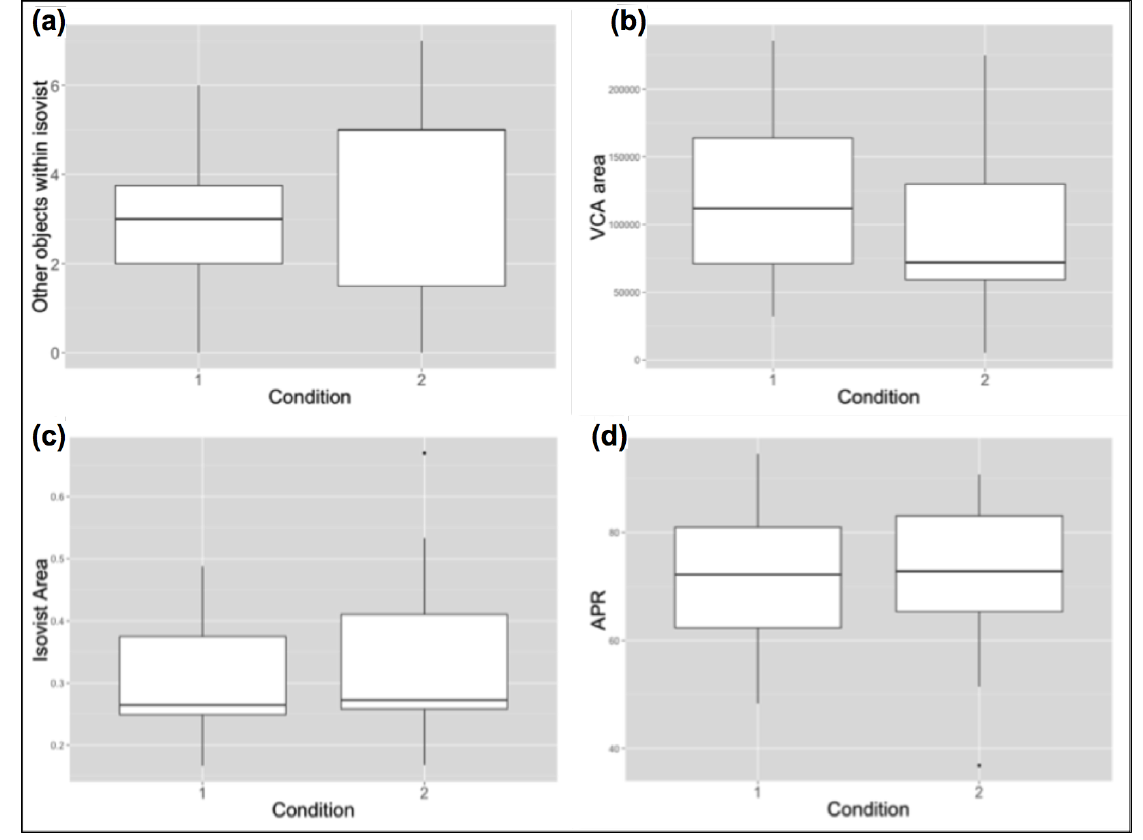
Figure 4. Boxplots presenting differences in spatial measures of picture locations between the two conditions: (a) Higher potential co-visibility in Cond; 2. (b) Lower average VCA in Cond; 2. (c) Similar isovist area sizes; (d) Similar area-to-perimeter